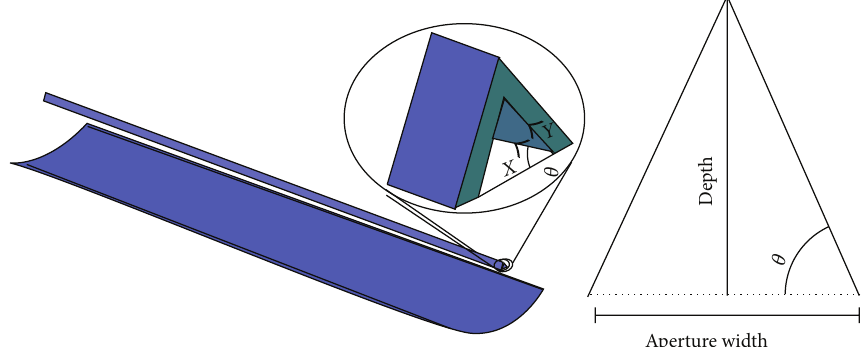
Figure 2: Optical properties simulation model of cavity absorber.